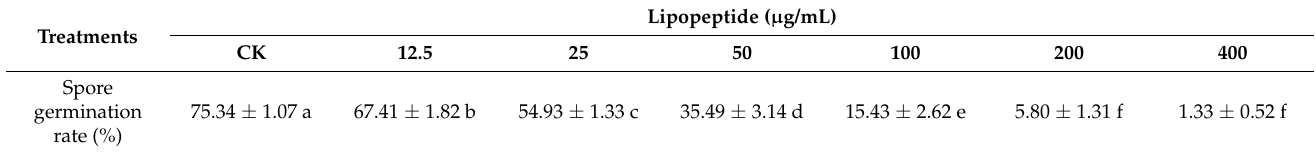
Table 3. Effects of different LPs concentrations on spore germination.